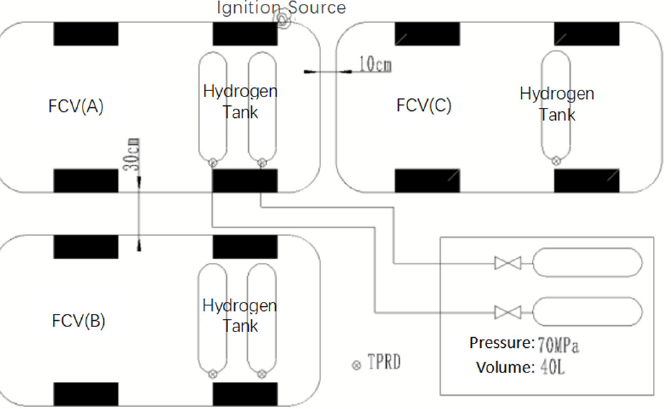
Figure 4. Multiple hydrogen fuel cell vehicles stored together in a centralized fire simulation test.